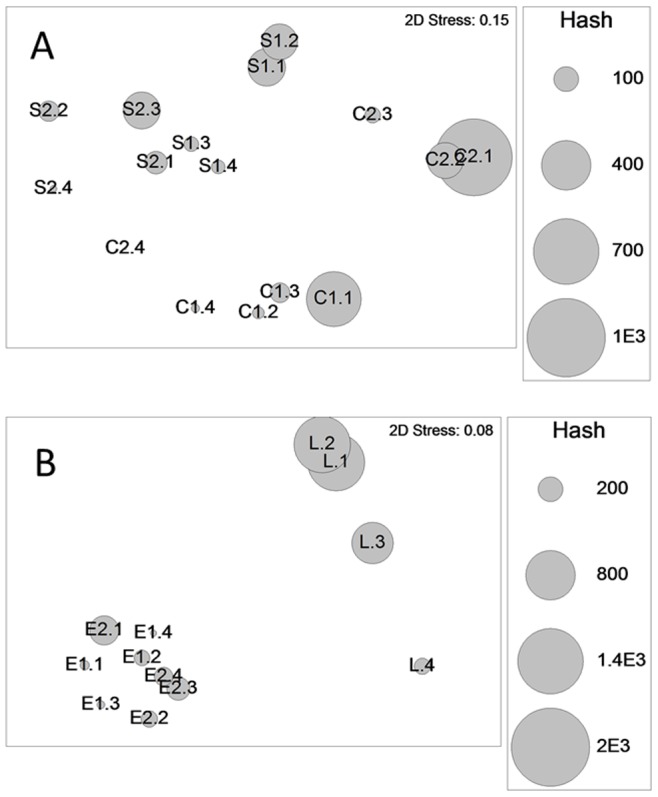
MDS relationship between assemblage, loch, distance-code and shell-hash content (bubble size).Note: a single ordination was first obtained which split the Sites into two distinct groups: (A) Creran and Spelve and (B) Etive and Leven which were analysed as MDS subsets. Bubble size indicates hash content (in g per grab), Code: C – Creran, E – Etive, L – Leven, S – Spelve, 1st number is the site (e.g. C1 is Creran 1 except for Leven where there was only one site), the second number is the distance code (1 is the closest to the mussel line; see methods). Note that the bubble scaling differs between the figures.